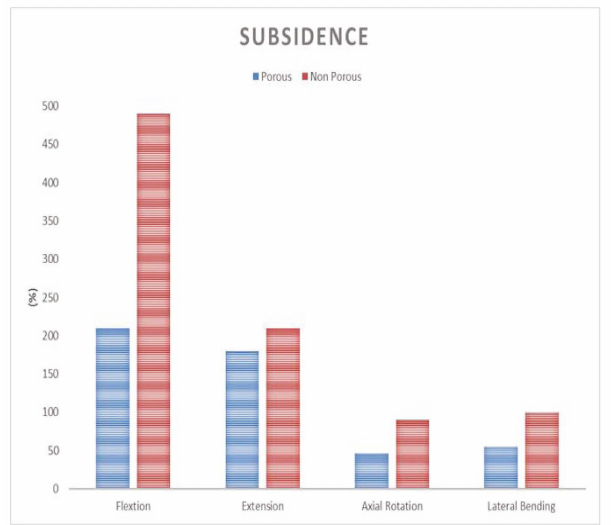
Figure 9. Comparison of subsidence likelihood in each